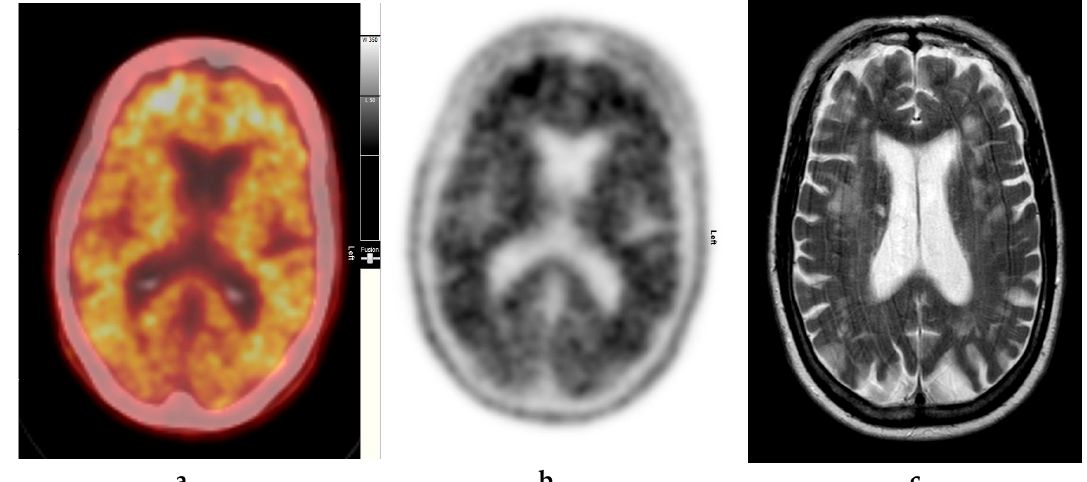
Figure 3. Abnormal study. Seventy-four year old male patient with a history of short term memory problems/gradual memory decline for some time and a query of dementing pathology. ( a ) and ( b ) [18F]FBP shows loss of contrast between grey and white matter in all sections of the brain. The scan is suggestive of beta-amyloid plaque deposition and in a patient with the above clinical presentation is suggestive of early AD. ( c ) MRI brain scan (multiplanar and multi sequence acquisitions) with some motion artefact shows generalised age appropriate cerebral atrophy, proportionate symmetrical temporal lobe atrophy, and corresponding dilatation of the cerebrospinal fluid (CSF) spaces. Moderate to marked periventricular T2 white matter hyperintensities likely to represent chronic small vessel ischemic changes. No diffusion restriction or space occupying lesions were identified. (Figures are courtesy RLBUHT Hospital database.).